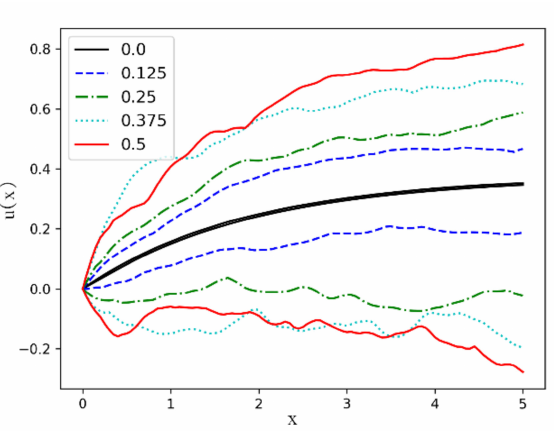
Figure 12. Comparative of U ( x ,100, σ ) and U ( x ,100, σ ) after 200 iterations for different values of the standard deviation: σ = 0.0 (black solid), σ = 0.125 (blue discontinued); σ = 0.25 (dark green dashed); σ = 0.375 (light green points) and σ = 0.5 (red solid).